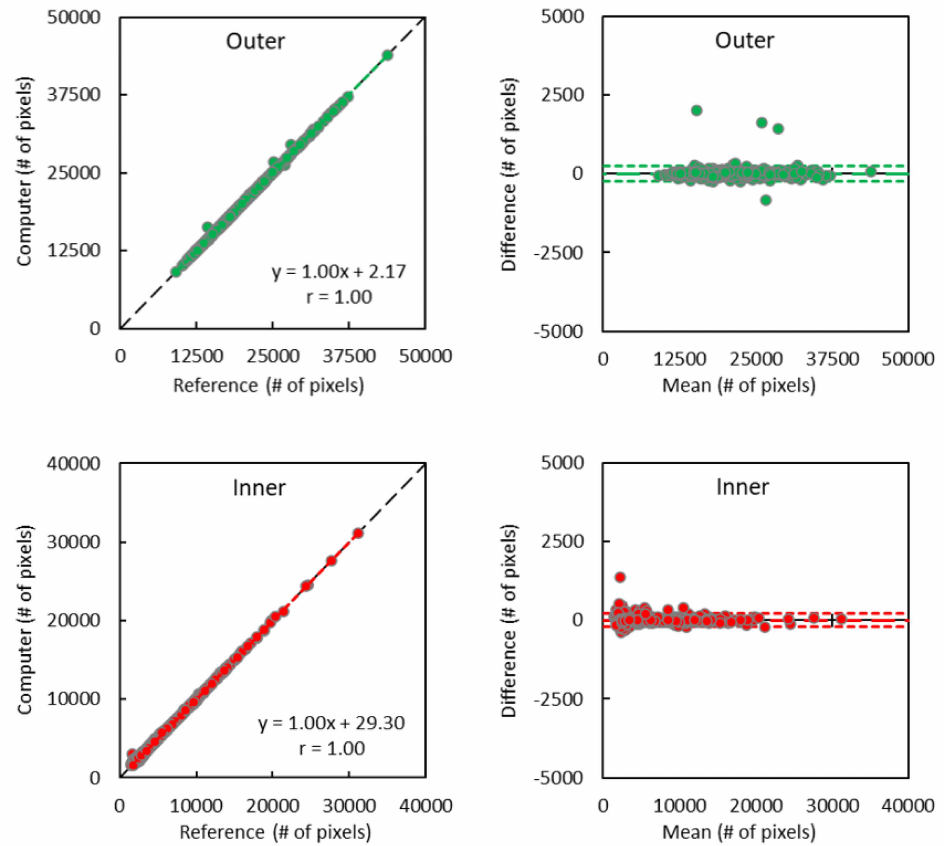
Figure 3. Pearson coefficients and Bland–Altman plots show excellent correlations and agreements between computer (convolutional neural network approach) versus reference (human) segmentation of the outer (green) and inner (red) abdomen regions. The dashed and dotted lines in Bland–Alman plots represent the bias and limits of agreement, respectively (mean ± 1.96